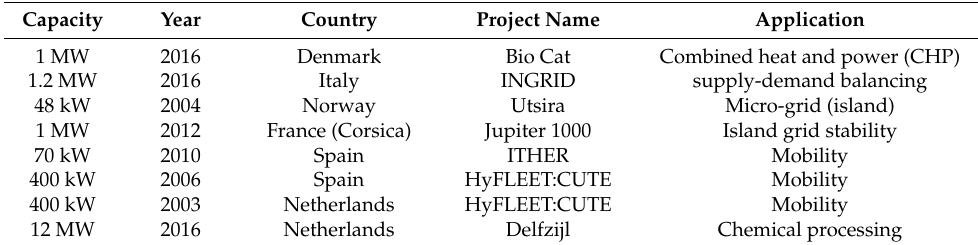
Table 9. Key P2G projects in Europe [111].